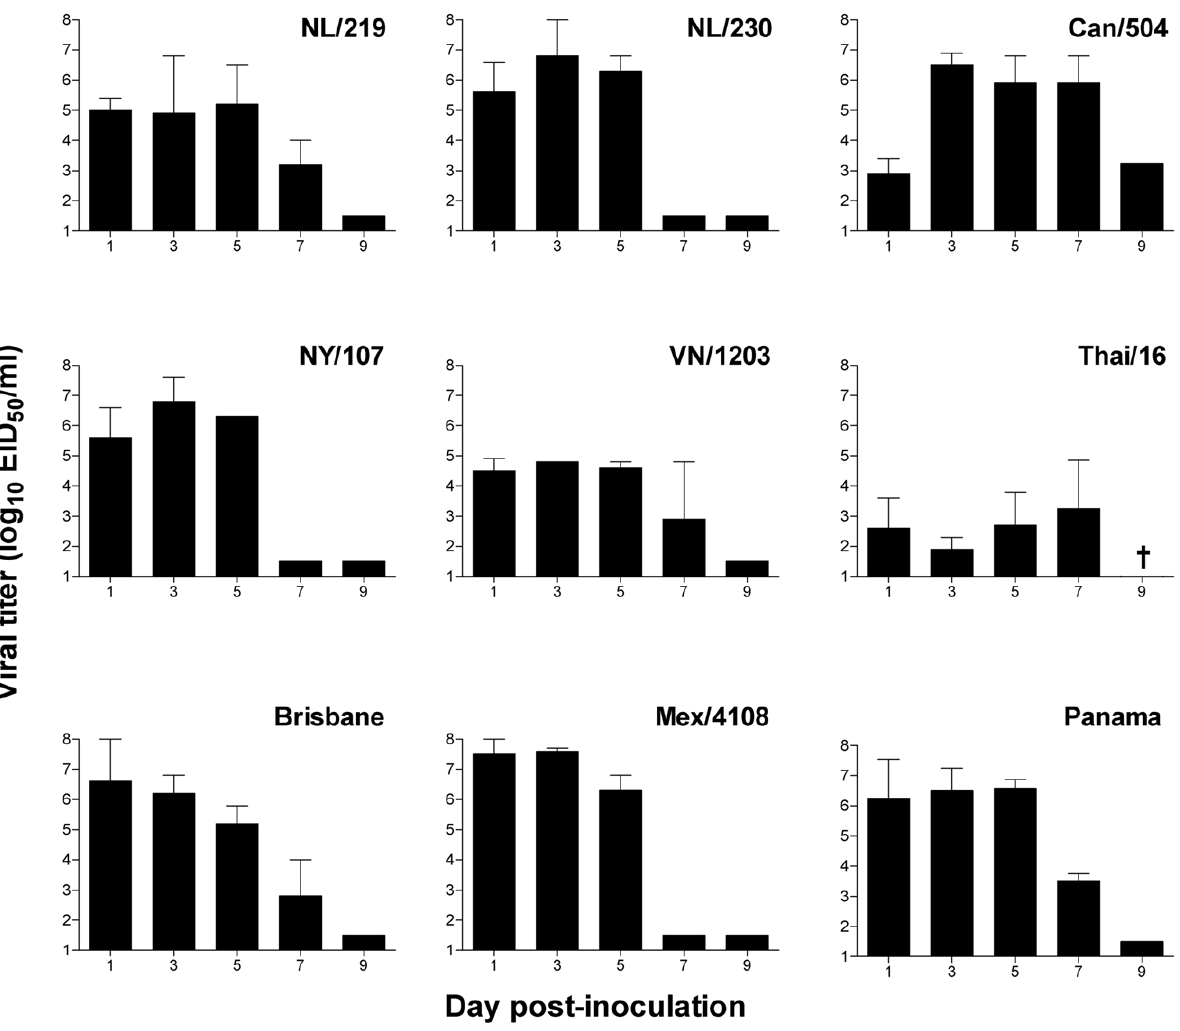
Figure 1. Comparison of mean titers of influenza viruses recovered from nasal wash following ocular inoculation of ferrets. Ferrets were inoculated by the ocular route with 10 6 EID 50 /ml of each virus shown. Viral titers were measured in nasal washes collected on indicated days following serial titration in eggs; endpoint titers are expressed as mean log 10 EID 50 /ml plus standard deviation. The limit of virus detection was 10 1.5 EID 50 /ml. { , ferrets did not survive to day 9 p.i. collected both left and right whole ferret eyes and all surrounding conjunctiva/eyelid for virus titration from ferrets inoculated by the intranasal or ocular route with NL/219, NL/230, or Brisbane viruses (Table 4). Surprisingly, sporadic viral titers from both left